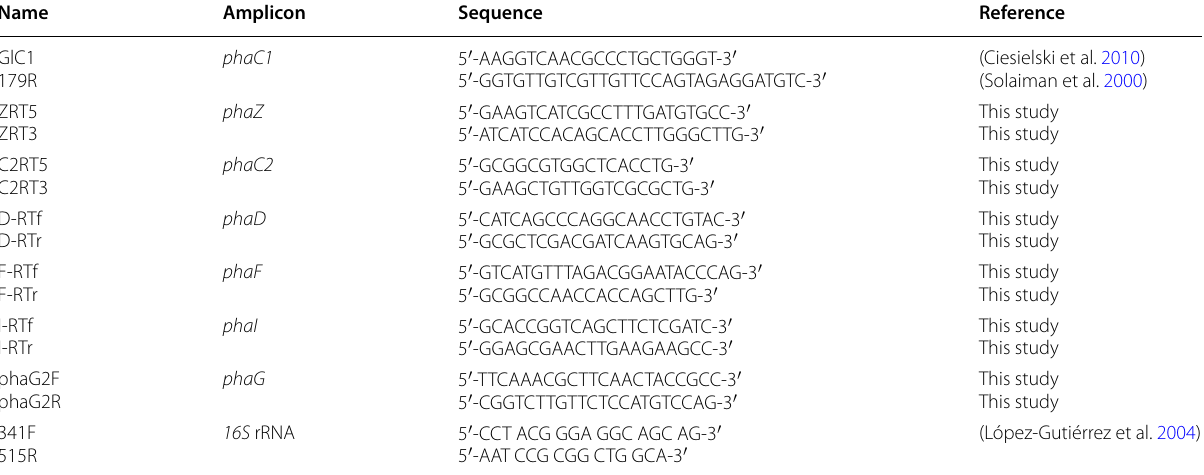
Table 1 Details of the PCR primers used in this study